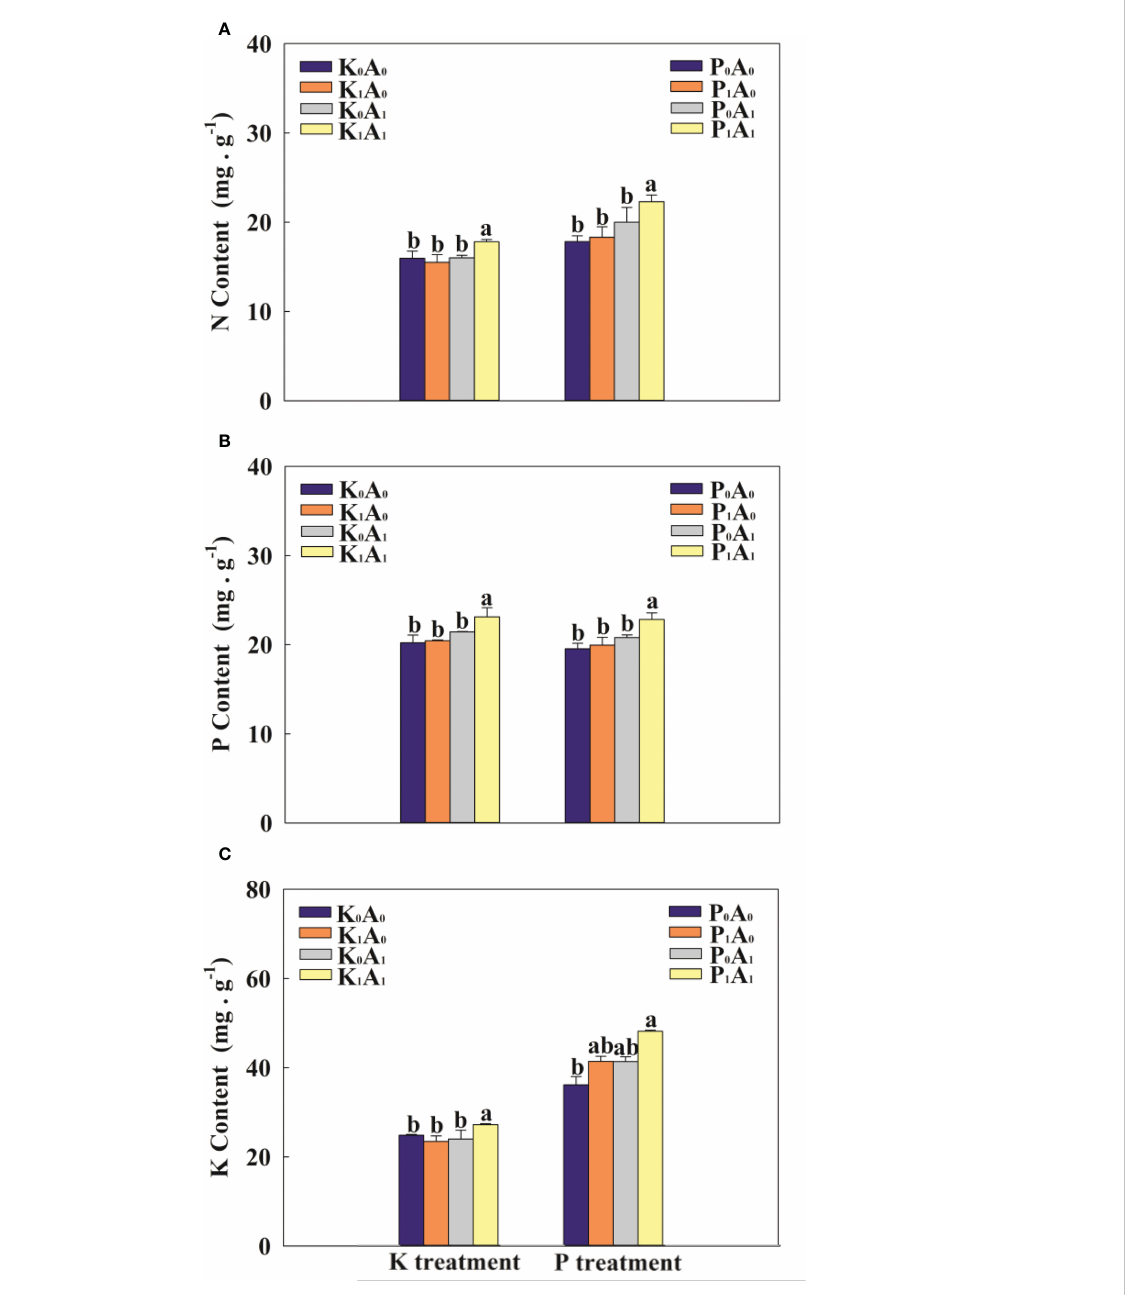
FIGURE 4 Effects of Aspergillus aculeatus on N content (A) , P content (B) and K content (C) of bermudagrass under K or P de fi ciency stress. K 0 A 0 represents no potassium feldspar and A. aculeatus treatment; K 1 A 0 represents only potassium feldspar treatment; K 0 A 1 represents only A. aculeatus treatment; K 1 A 1 represents potassium feldspar + A. aculeatus treatment; P 0 A 0 represents no tricalcium phosphate and A. aculeatus treatment; P 1 A 0 represents only tricalcium phosphate treatment; P 0 A 1 represents only A. aculeatus treatment; P 1 A 1 represents tricalcium phosphate + A. aculeatus treatment. Columns marked with the same small letter indicate insigni fi cant differences between the four treatment groups ( p <